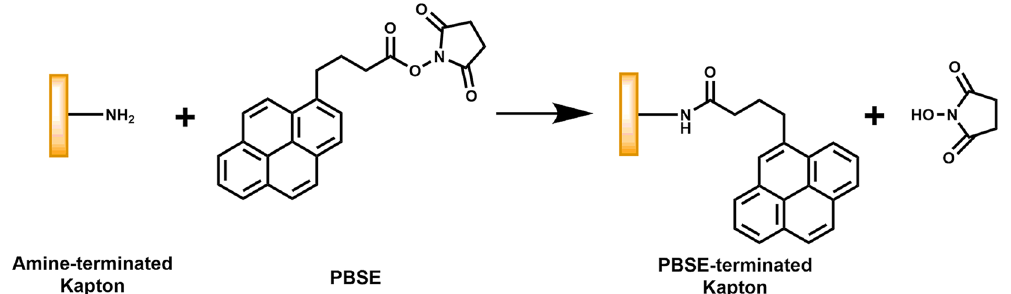
Figure 7. Reaction of the amine-terminated Kapton ® substrate with 1-pyrenebutyric acid N-hydroxysuccinimide ester (PBSE).